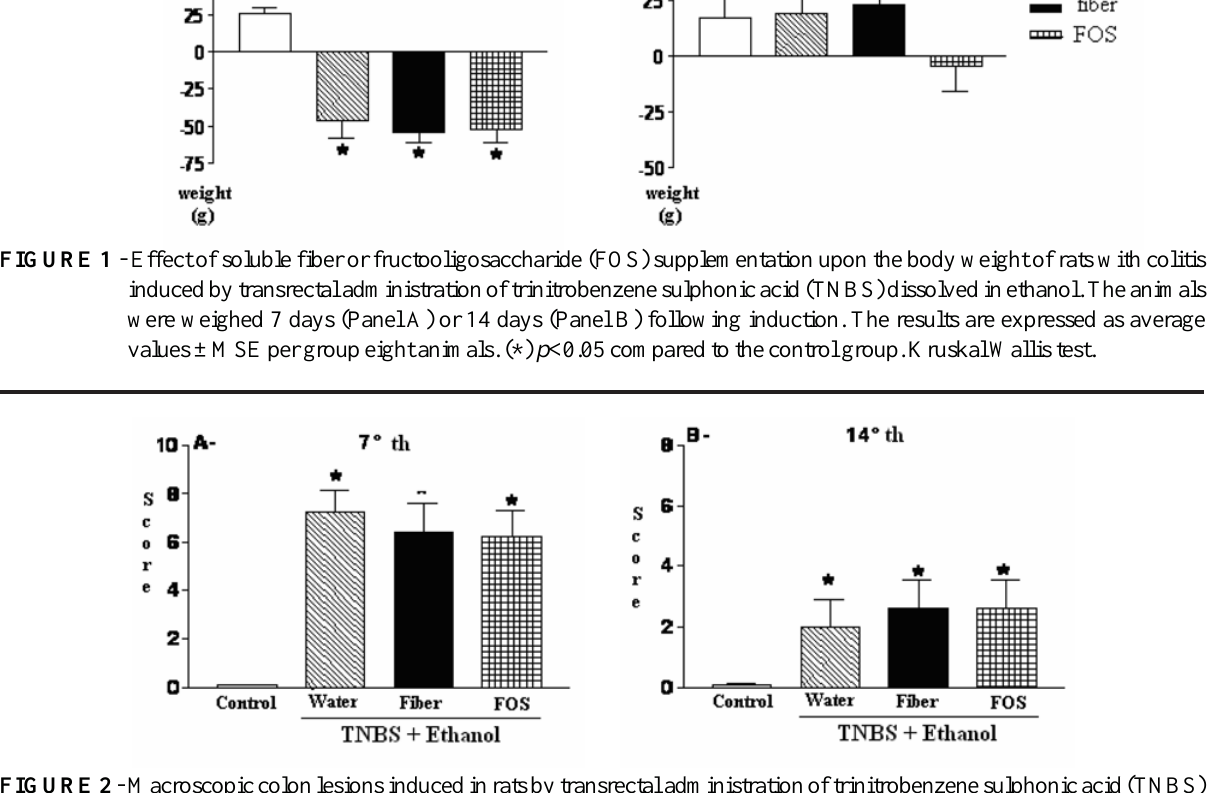
FIGURE 2 - Macroscopic colon lesions induced in rats by transrectal administration of trinitrobenzene sulphonic acid (TNBS) dissolved in ethanol were not inhibited by supplementation with soluble fiber or fructooligosaccharide (FOS). Colon lesions were evaluated on the 7th day (Panel A) or the 14th day (Panel B). The results are expressed as average values ± MSE per group eight animals.. (*) p <0.05 compared to the control group. Kruskal Wallis test.